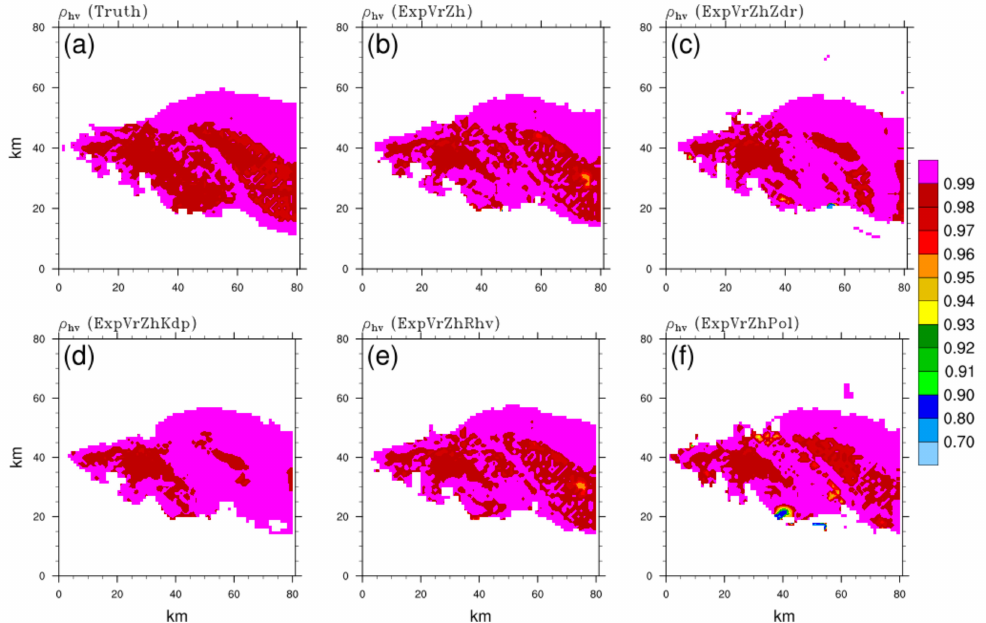
Figure 6. The same as Figure 3, but for the cross-correlation coefficient ρ hv (dimensionless) of ( a ) truth, and analysis fields of ( b ) ExpVrZh, ( c ) ExpVrZhZdr, ( d ) ExpVrZhKdp, ( e ) ExpVrZhRhv, and ( f ) ExpVrZhPol,